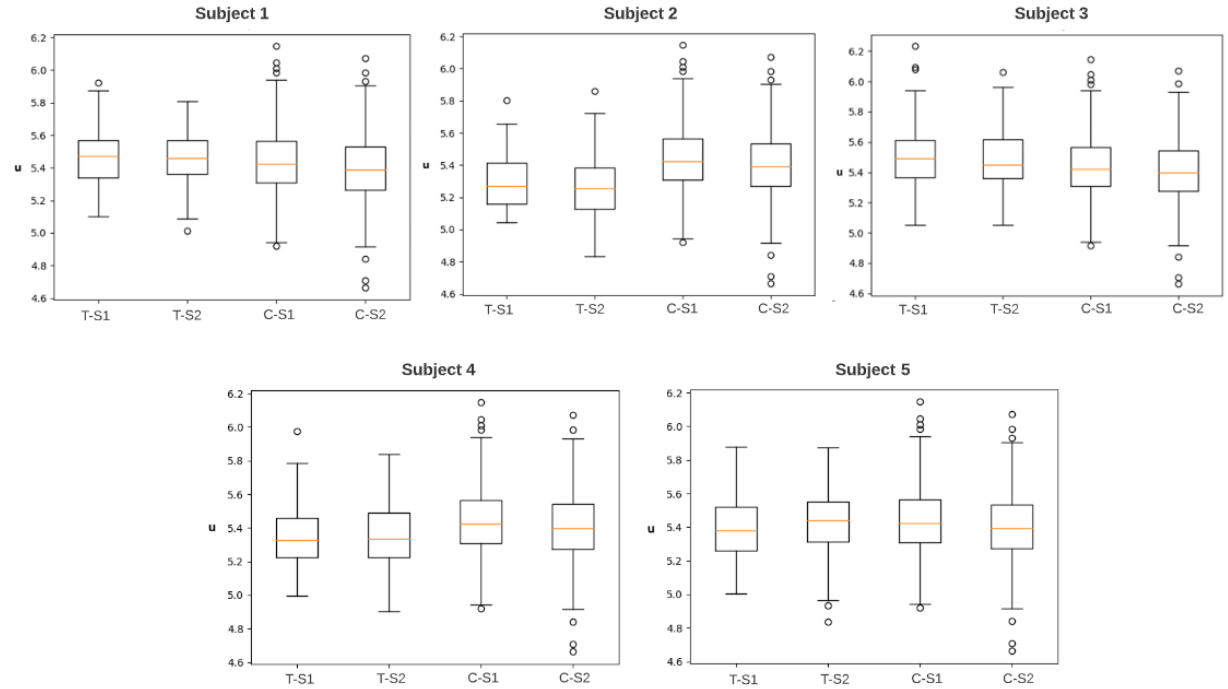
Figure 7. Box plots of five subjects as a result of between-subjects design to obtain the statistical distribution between-tinnitus subjects versus control participants in two monitoring sessions. T- S1: tinnitus group before the sound-based treatment, T-S2: tinnitus group after the sound-based treatment, C-S1: control group before the sound-based treatment, C-S2: control group after the sound-based